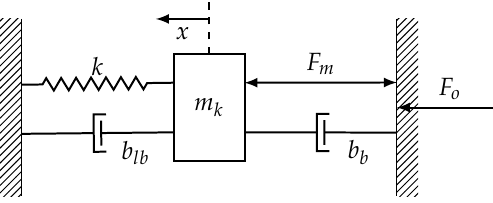
Figure 6. Model of RFSEA for force control with high impedance